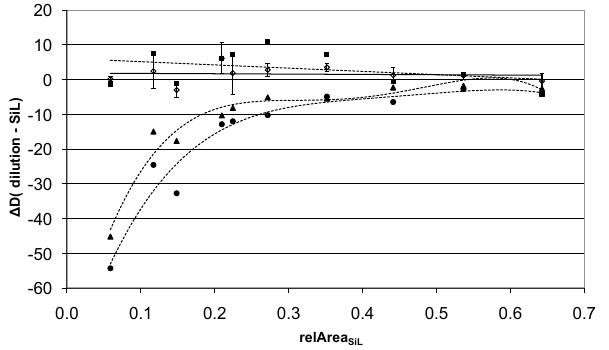
Fig. 7. Reproducibility distribution. The line breaks indicate a change of the x-axis scale. ♦ SPI, (cid:4) “Individual BDG”, N “Me- dian BGD”, • “TimeBased BGD